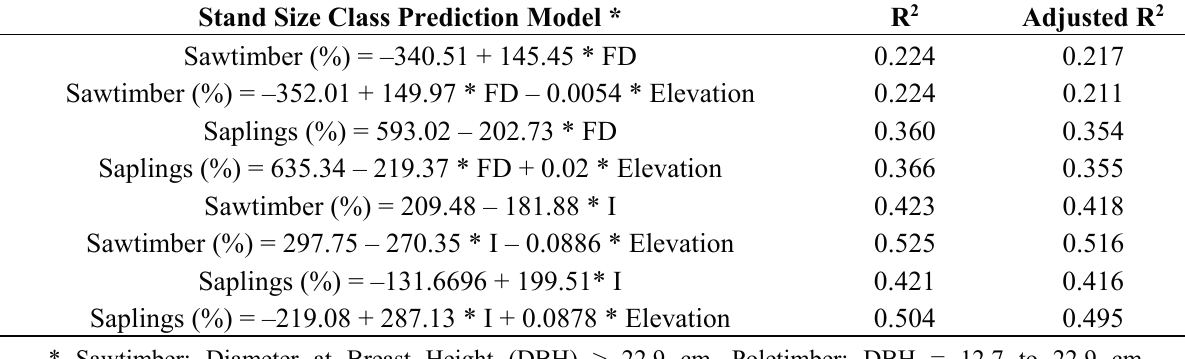
Table 6. Stand Size Classes Prediction